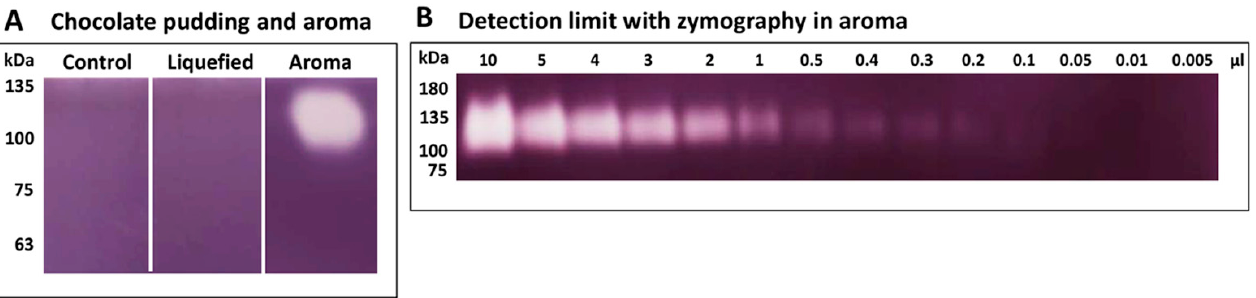
Figure 3. Assay for starch degrading enzymes by zymography. ( A ) No activity detectable in control pudding or liquefied pudding, but in aroma from liquefied pudding (right trace, white spot indicates digestion of starch). ( B ) Starch digestion in respective aroma is detectable down to 0.1µL. The detection limit of this assay was investigated to be around 0.5–20 ng, depending on the present amylase.